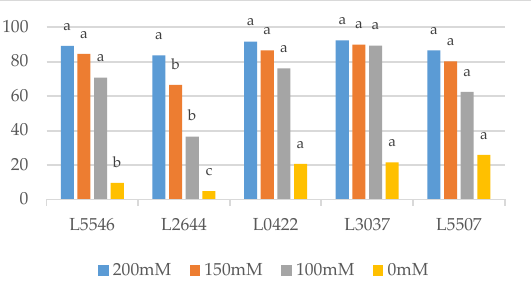
Figure 2. Electrolyte leakage of five alfalfa lines measured after 10 weeks on culture medium enriched with 0, 100, 150 and 200 mM. The histograms represent the average of 20 replicates. The different letters show the statistical differences among the varieties for each salt treatment. (Test SNK- p ≤ 0.01).